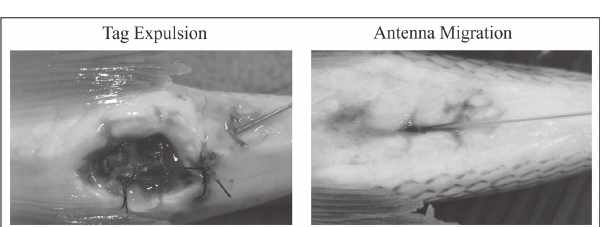
Fig. 2. Examples of tag expulsion (left) and antenna migration (right) of Prochilodus lineatus .